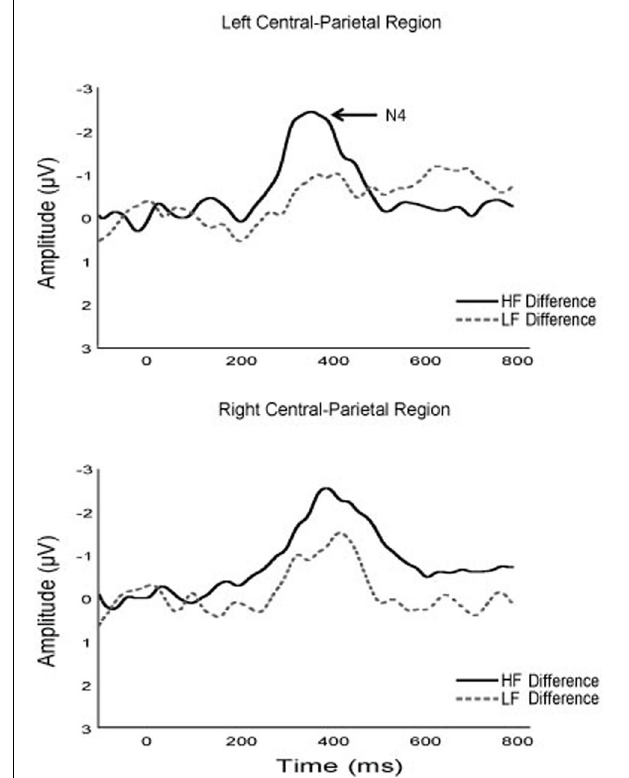
FIGURE 5 | Grand average difference waveforms of the N400 component for higher and lower fit